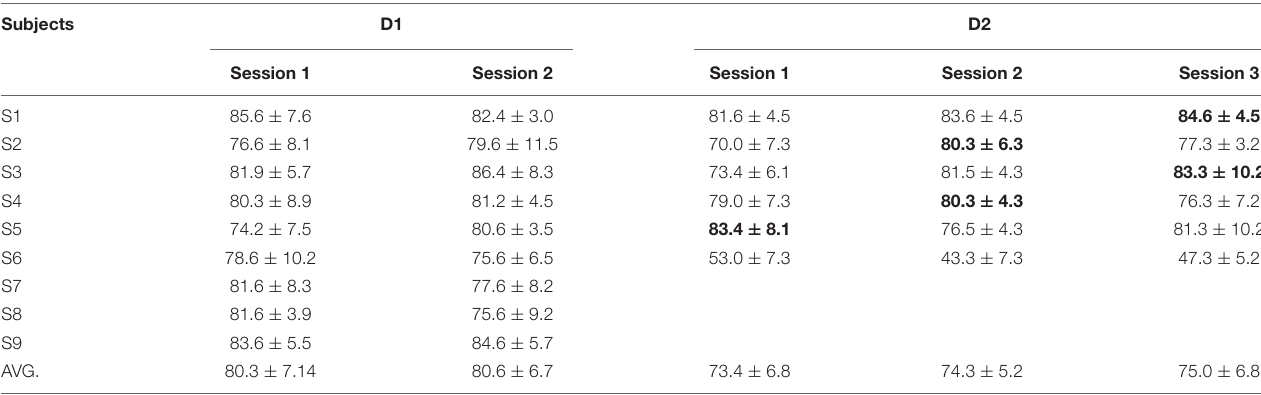
Bold values indicates best result of the